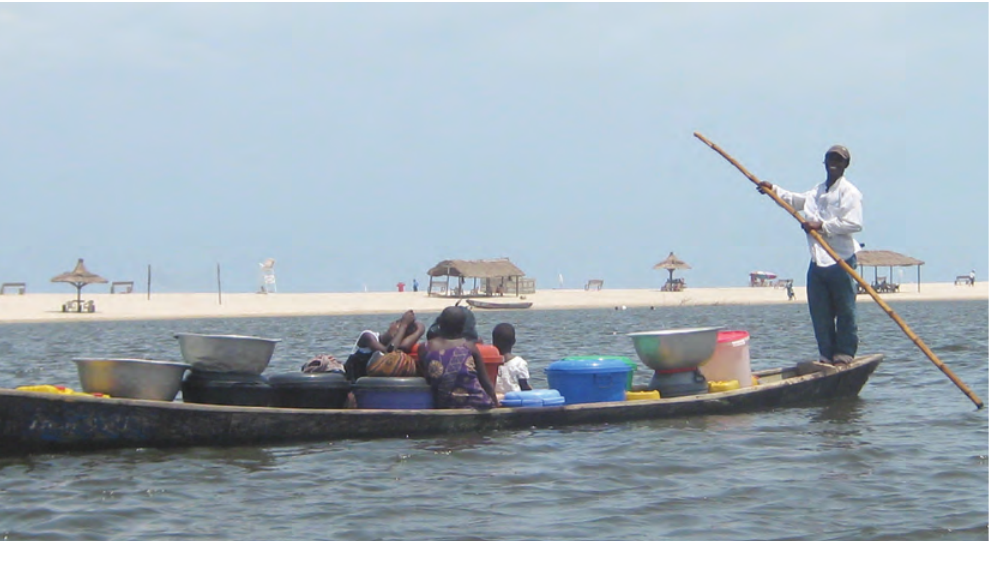
Source: Field survey, May 2010.